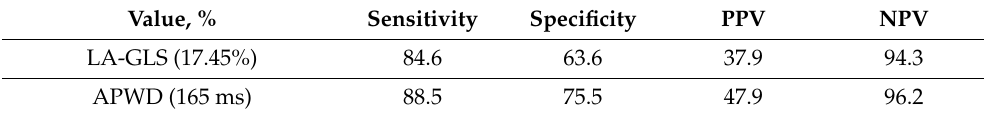
Table 3. Diagnostic value of thresholds.